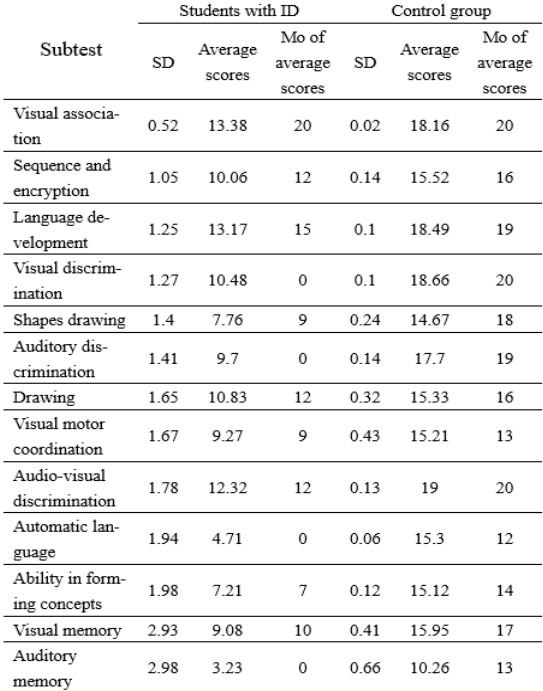
Table 1. Obtained results in the